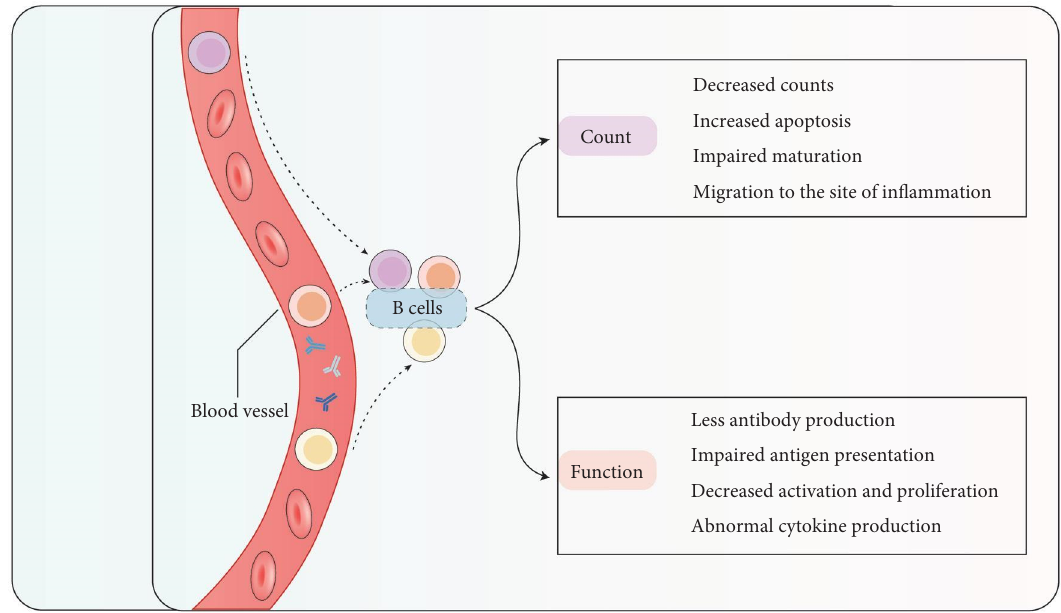
F IGURE 2: Changes of circulating B cells in patients with sepsis. Signi fi cant alterations in both the counts and function of circulating B cells were observed in patients suffering from